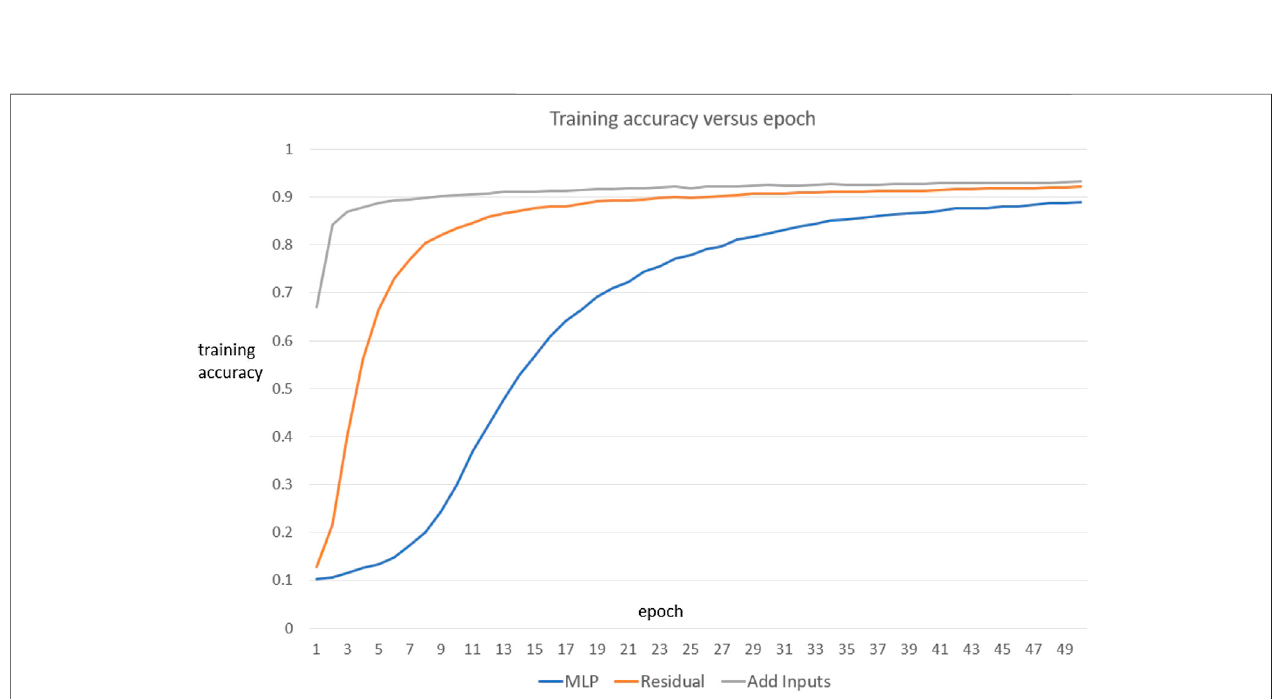
FIGURE 7 | Fitting a multilayer perceptron, a residual network, and an add-inputs network to 10 , 000 MNIST images. With the additional training data using structured images the fl exibility of the add-inputs network leads to better performance (see Table 1 for the testing accuracies).